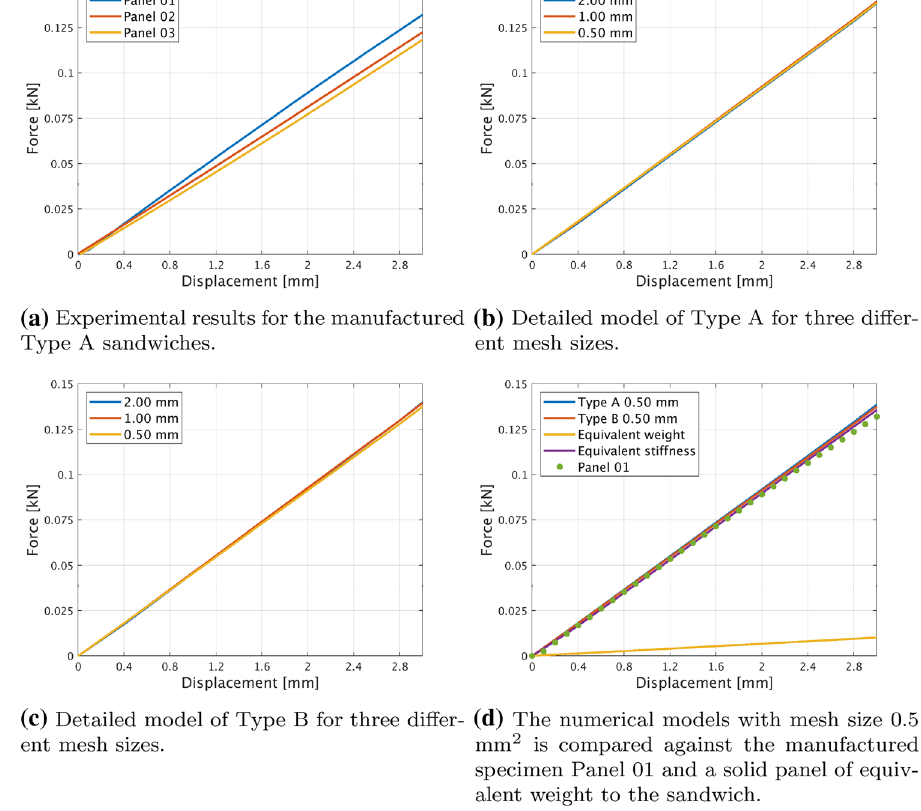
Fig. 11 Results from the experiments and